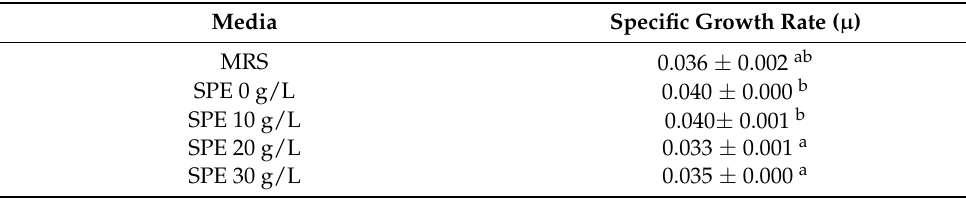
Table 2. Specific growth rate of Lpb. plantarum TISTR 2075 in MRS and sweet potato extract (SPE) mixed with 0, 10, 20, and 30 g/L of soybean powder